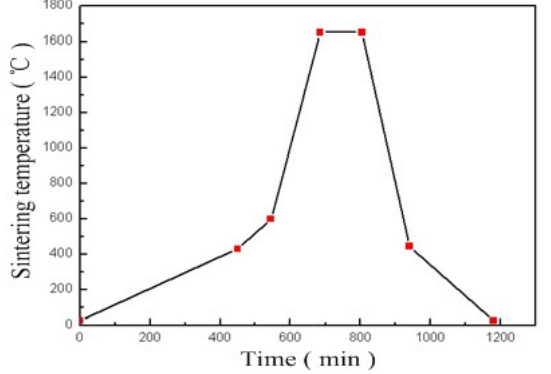
Figure 4. Ceramic substrate curing sintering